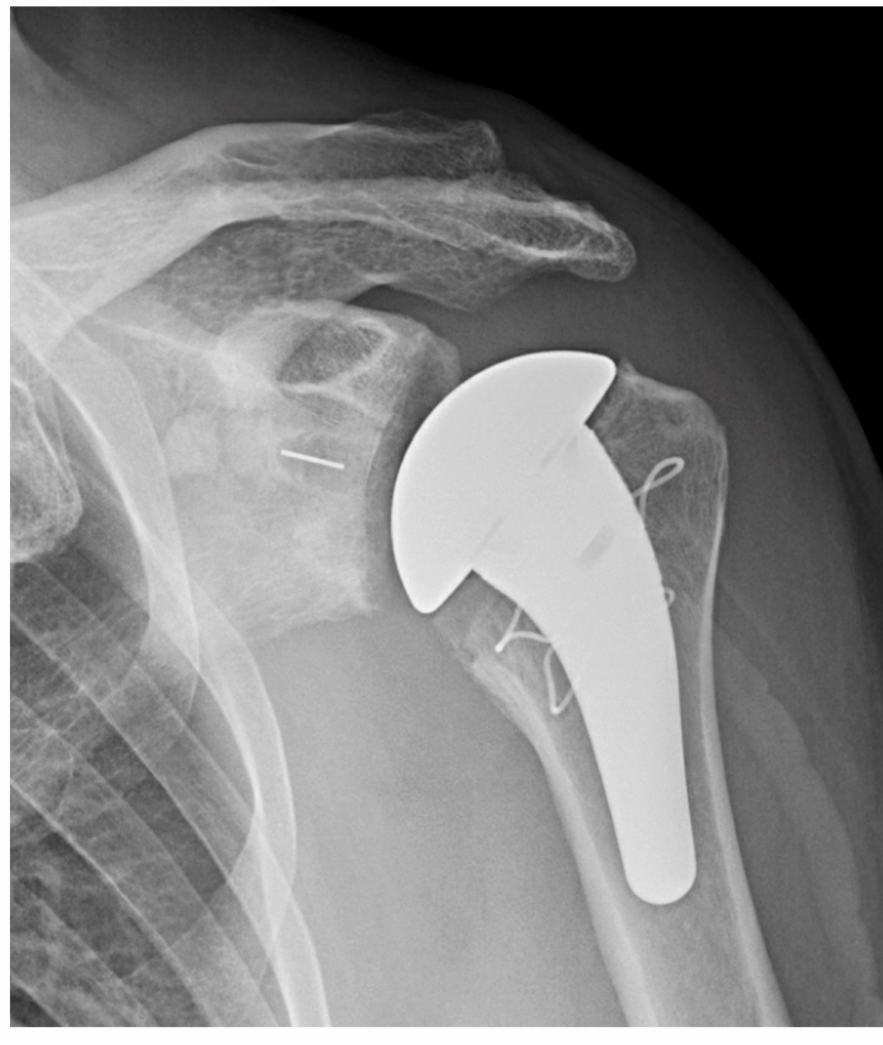
Figure 2. Short stem anatomic TSA. AP X-ray of anatomic TSA with short humeral